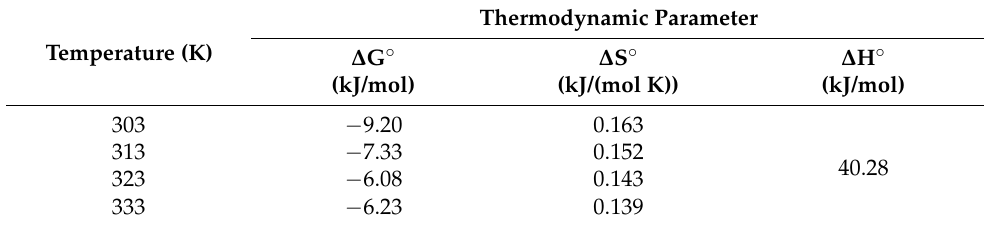
Table 3. Langmuir parameters and thermodynamic